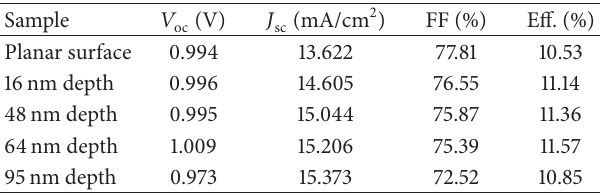
Table 1: Current density-voltage characteristics of the GaAs single- junction solar cells with various depths of the nano-hole